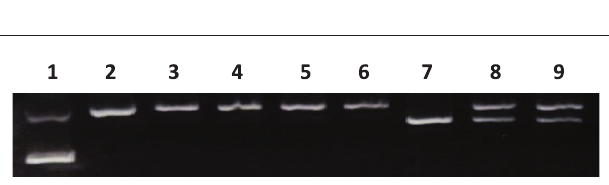
Figure 6 | Confirmation of the mismatch DNA substrate. Lane 1: supercoiled DNA; Lane 2: Nick DNA control (Nt. BbvCI-digested); Lane 3, 4: G/T and G/IU nick DNA substrate; Lane 5, 6: NheI digestion of lane 3, 4; Lane 7: NheI digestion of pWDAH1A plasmid, linear; Lane 8: G/T nick DNA substrate + NE + proteinase K digestion, DNA extraction using ethanol + NheI digestion; Lane 9: G/IU nick DNA substrate + NE + proteinase K digestion, DNA extraction using ethanol + NheI